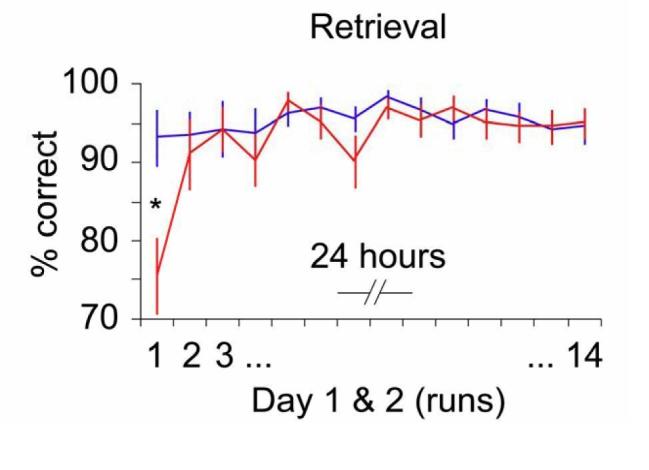
Schema retrieval across days.Data represents the % of correct responses. Error bars denote ± Standard Error of the Mean (SEM). * marks a significant (P < 0.05) difference between the schema conditions within the first run of day 1.